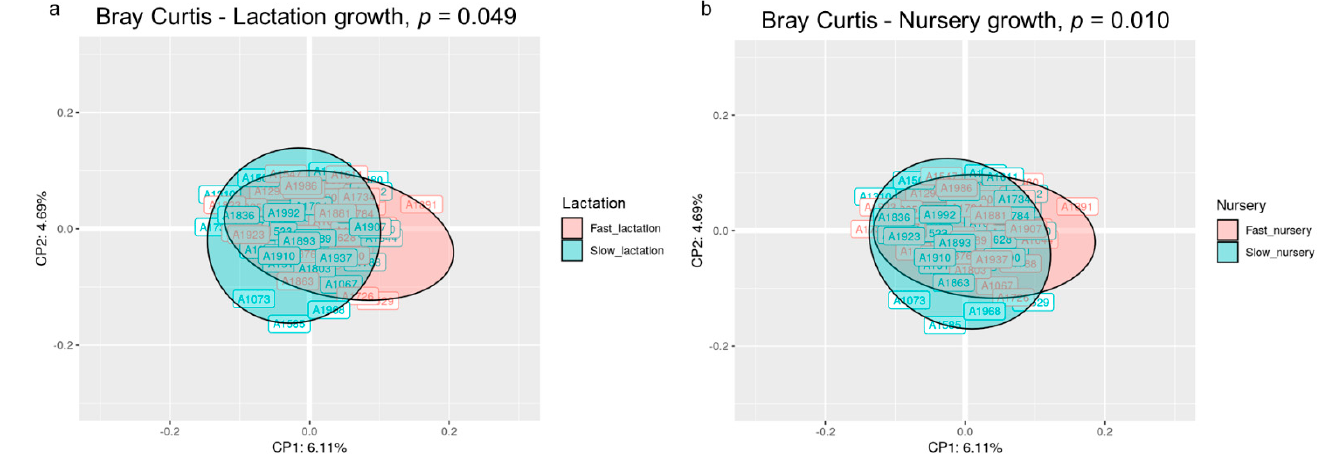
Figure 1. Principal coordinate analysis (PCoA) ordination performed by Bray–Curtis dissimilarities representing the microbiome compositions of all animals clustered by lactation growth ( a ) and nursery growth ( b ). The p -value corresponds to the permutational analysis of variance (PERMANOVA) test for each factor. Sample size for the PCoA: Fast_Fast ( n = 19), Fast_Slow ( n = 18, missing samples = 1), Slow_Fast ( n = 17, missing samples = 2), and Slow_Slow ( n = 17, missing samples = 1).